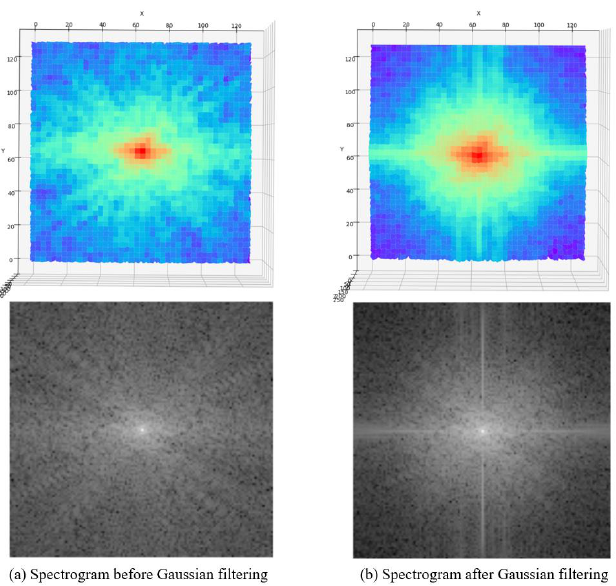
Figure 7. Changes in the spectrogram before and after Gaussian filtering.